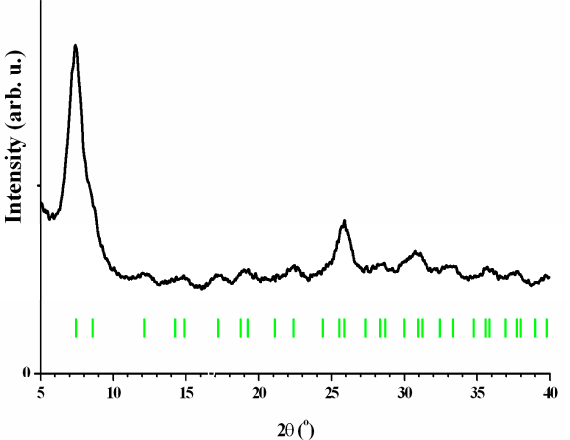
Figure 6. The Rietveld plot for the meso-UiO-66 material showing the experimental (black dots), calculated (blue) and difference (red) curves. The vertical green bars denote calculated positions of the peaks for the cubic crystal structure UiO-66.